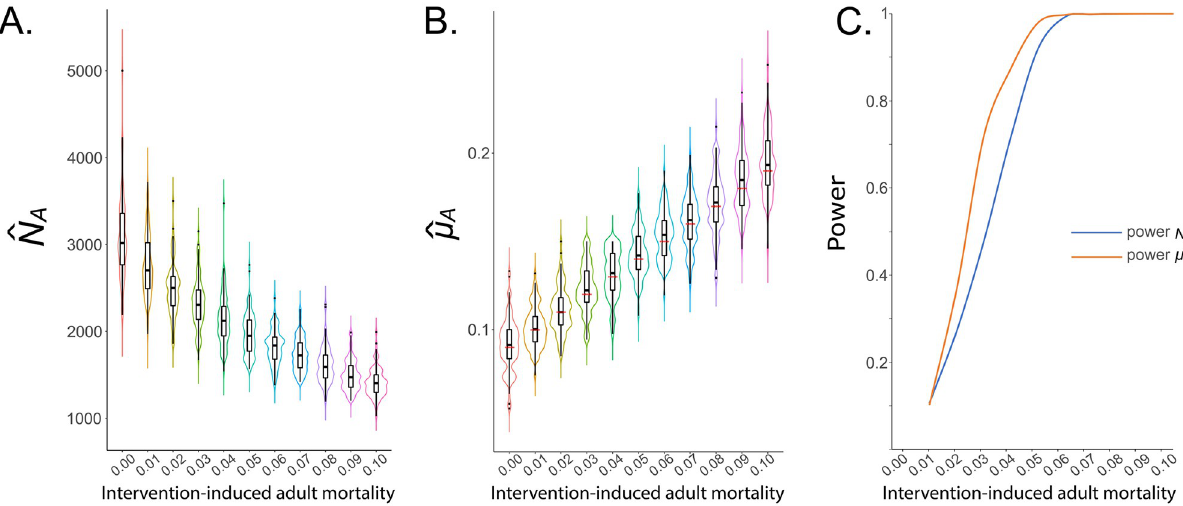
Fig 8. Application of CKMR methods to infer intervention impact. CKMR methods are applied to a simulated population of 3,000 adult Ae. aegypti with bionomic parameters listed in Table 1 and the optimal sampling scheme for estimating adult parameters (a total of 1,000 adult females sampled biweekly over three months). Fogging is simulated as an intervention that elevates adult mortality. In panels (A-B) , violin plots depict estimates of N A and μ A for fogging-induced adult mortality rates of 0.01–0.10 per day (increased in 0.01 per day increments). Boxes depict median and interquartile ranges of 100 simulation-and-analysis replicates for each intervention-induced mortality rate, thin lines represent 5% and 95% quantiles, points represent outliers, and kernel density plots are superimposed. In panel (B) , actual intervention-modified adult mortality rates are denoted by red lines. Results depict a pattern of increasing estimated μ A and decreasing estimated N A in response to increasing fogging-induced mortality rates. In panel (C) , the statistical power to detect an increase in μ or a decrease in N is depicted, assuming a type I error rate of 5%. A A